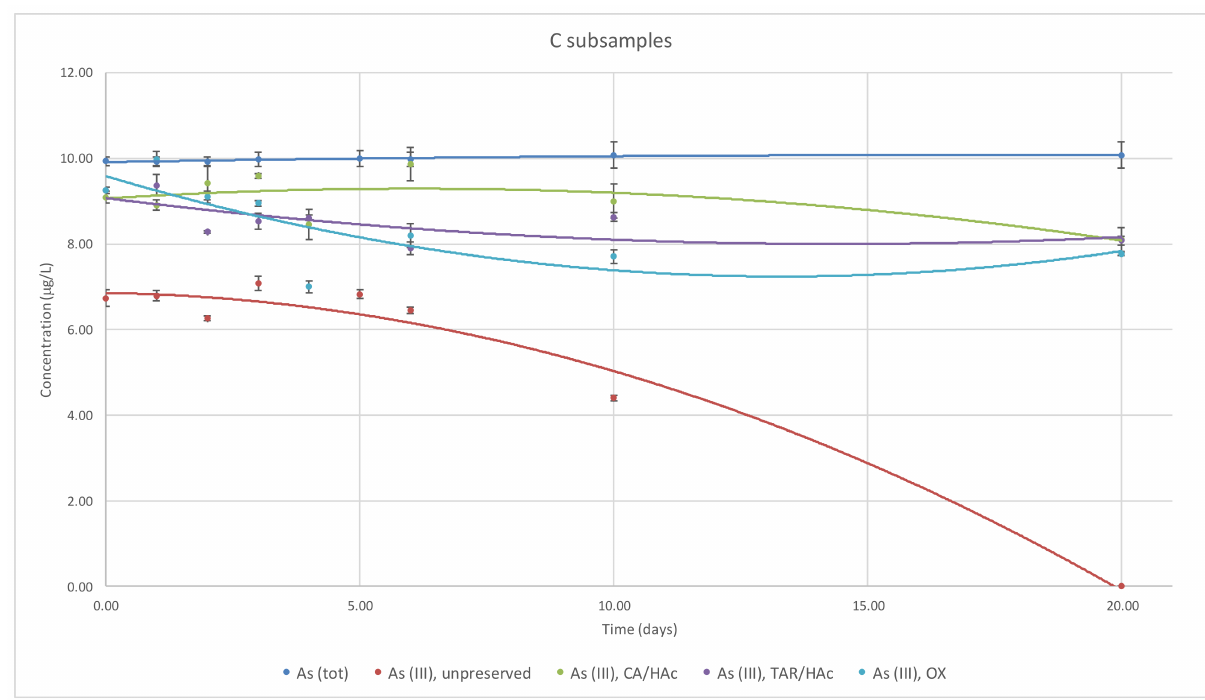
Figure 6. As(III) and As(tot) stability over time, dependent on the preservation treatment used—natural water sample C.